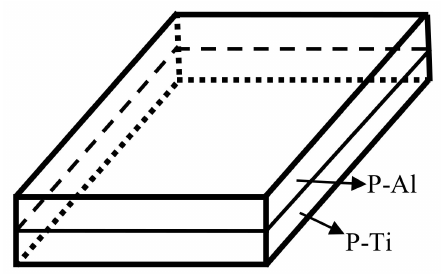
Figure 1. Schematic of the Al-Ti composite